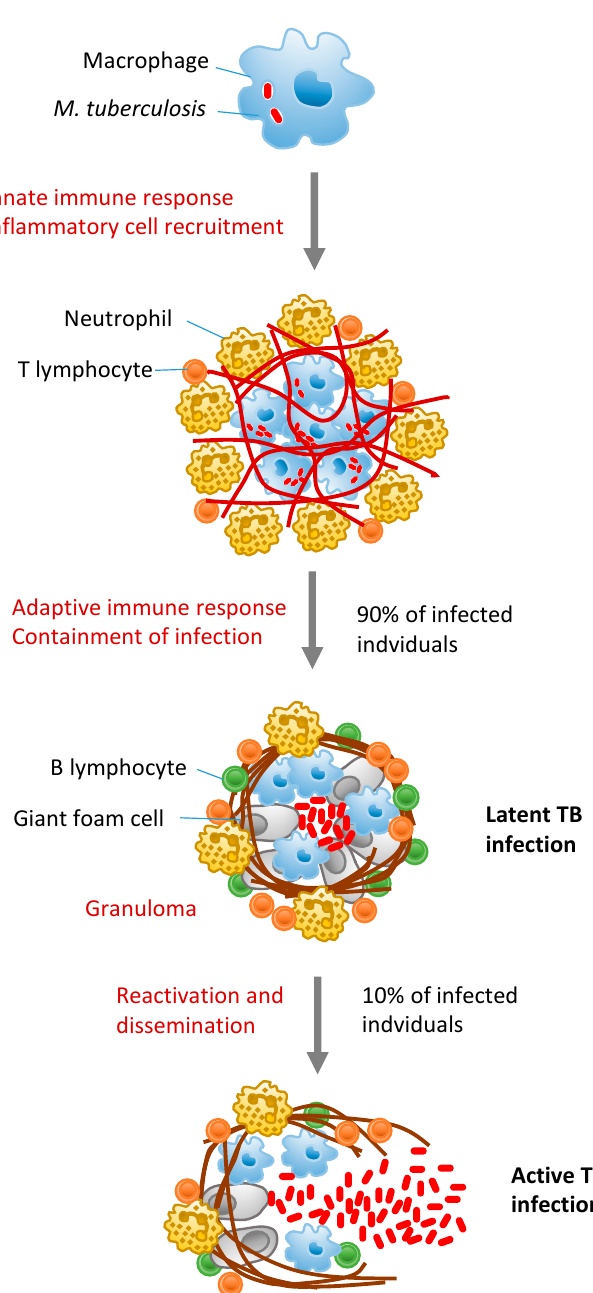
Figure 1. Tuberculosis pathogenesis and disease progression. Mycobacterium tuberculosis infection initiates with inhalation of droplets that carry bacteria and their uptake by alveolar macrophages. Innate immune responses characterize the initial phase of infection, with recruitment of inflammatory cells in the lung. Bacterial dissemination to the draining lymph node leads to T cell priming and expansion of antigen-specific T cells. Recruitment of activated macrophages, neutrophils, T cells, and B cells in the lung leads to granuloma formation, which contains M. tuberculosis in a latent status. However, in about 10% of infected individuals, M. tuberculosis escapes immune control and granulomas are disrupted, with release of infectious bacteria.